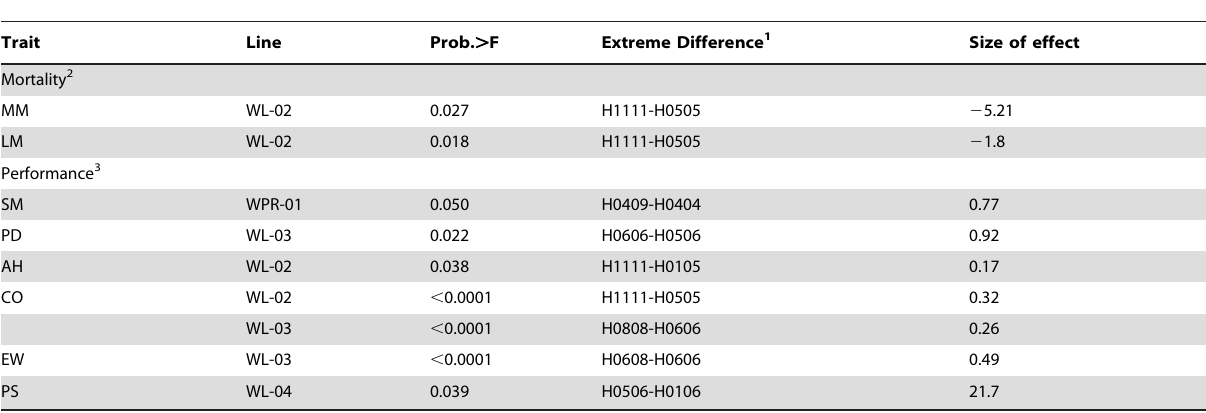
Table 6. Mx haplotypes with significant effect.